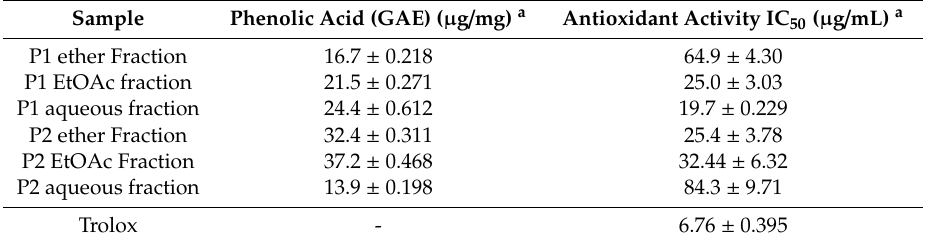
Table 2. Phenolic content and antioxidant activity of T. sapiens propolis collected from two regions (P1 and P2).